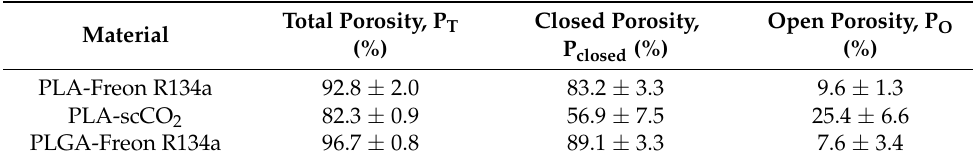
Table 2. Porosities of the studied 3D porous scaffolds.